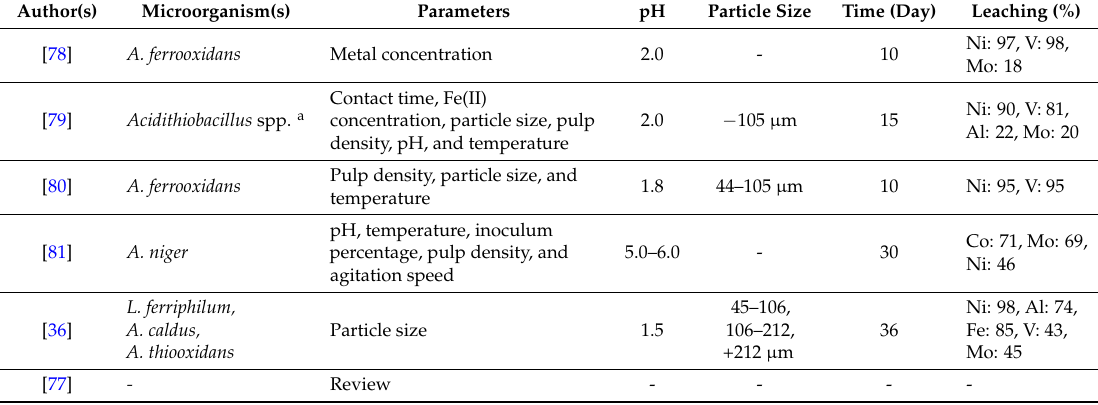
Table 5. Bioleaching research of spent catalysts according to the parameters studied and recoveries achieved as well as microorganisms used in the studies. The articles appear in chronological